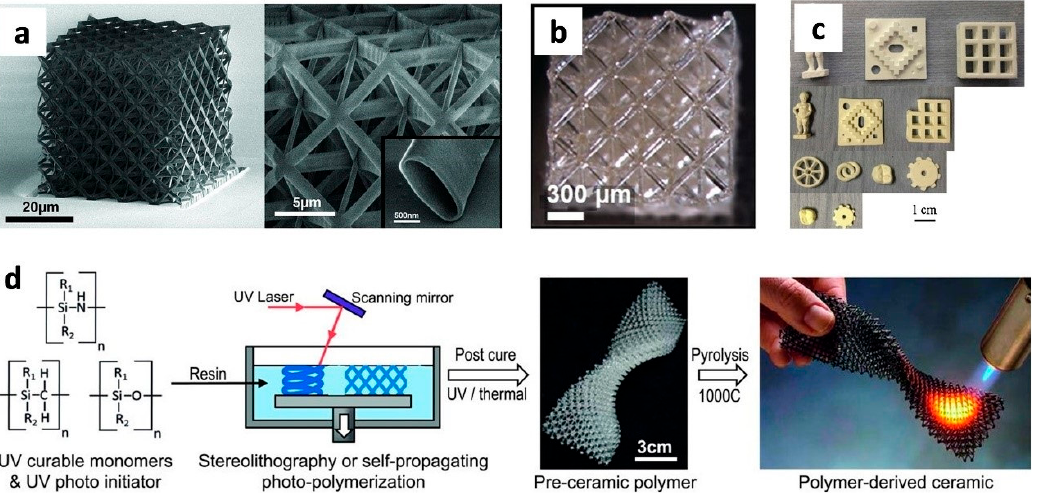
Figure 6. Examples of some common 3D printing procedures for ceramics. Small ‐ scale ceramics may be 3D printed using coating ‐ film ‐ based ceramic printing feedstocks. ( a , b ): ( a ) an Al 2 O 3 nanolattice with hollow tubes [104]. ( b ) Al 2 O 3 hollow ‐ tube micro ‐ lattice [98]. ( c , d ) Large ‐ scale ceramics printed in 3D: ( c ) selective laser sintering [95] and ( d ) stereolithography (SLA)/self ‐ propagating photopolymer wave ‐ guide technique for ceramics generated from polymers [93].